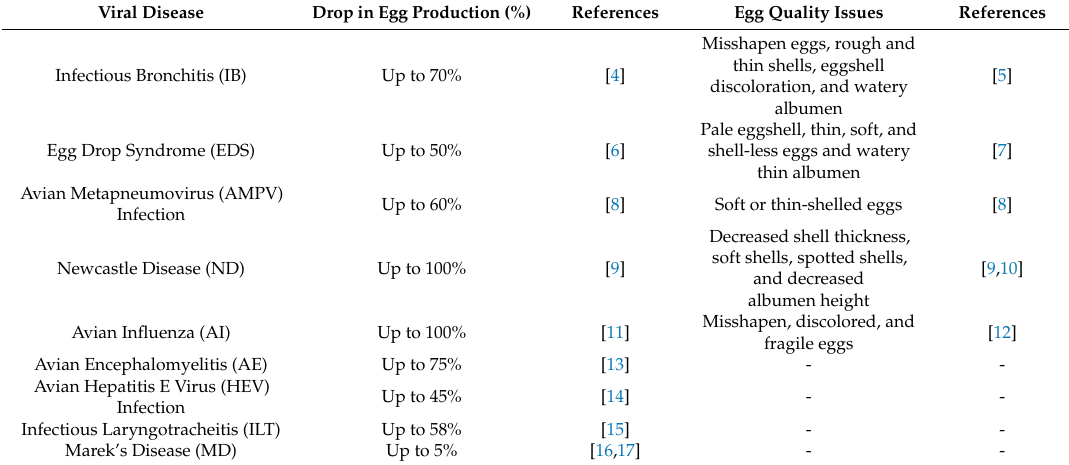
Table 1. Adverse e ff ects on egg production and quality observed in di ff erent viral diseases.